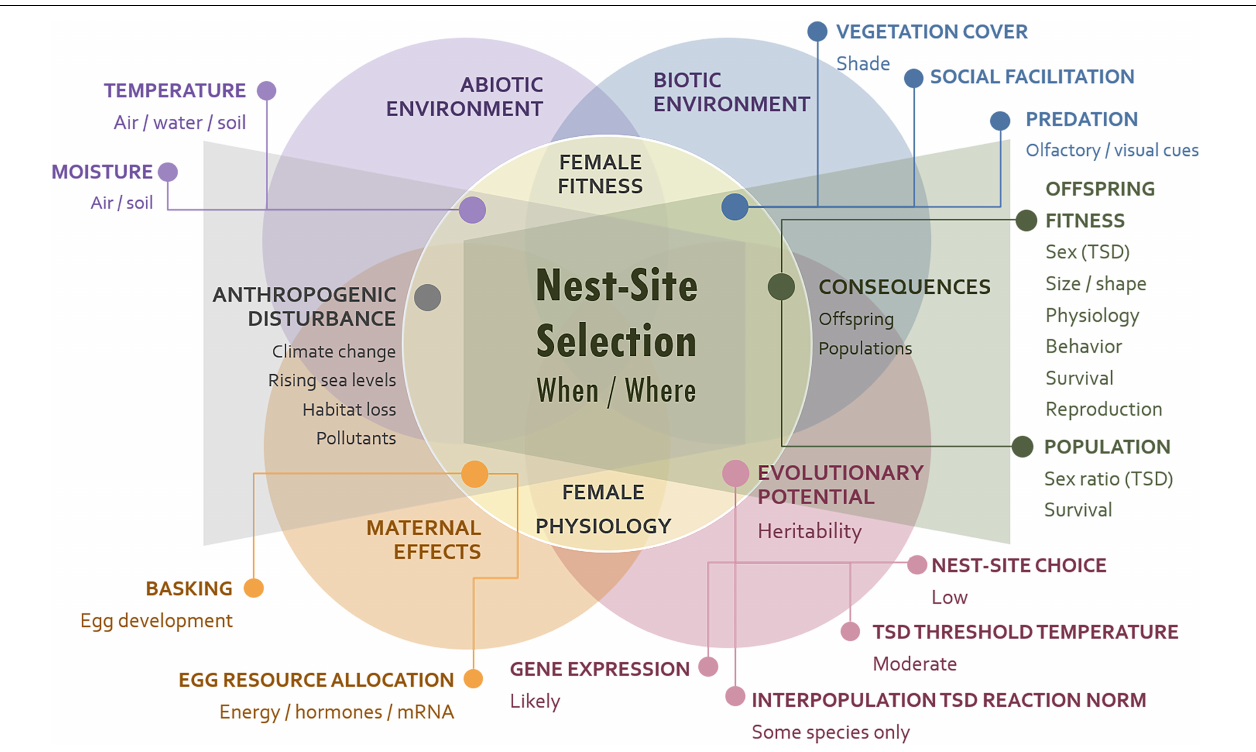
FIGURE 1 | Causes and consequences of nest-site choice. Biotic factors, e.g., predation risk, social facilitation, and vegetation cover, impact nest-site selection directly, whereas abiotic factors may have indirect effects, via their influence of air and water temperature on basking behavior and egg resource allocation. Vegetation cover plus air temperature and humidity affect the thermal and moisture conditions of the soil and those experienced by the developing embryos, thus impacting offspring phenotype and fitness, and population dynamics. Anthropogenic disturbances are detrimental for habitat quality and incubation conditions, and adaptive responses are less likely for nesting behaviors than for TSD reaction norms or for developmental gene networks. In TSD species whose reaction norms vary among localities, habitat loss may preclude recolonization of populations extirpated by environmental change from other populations pre-adapted to altered